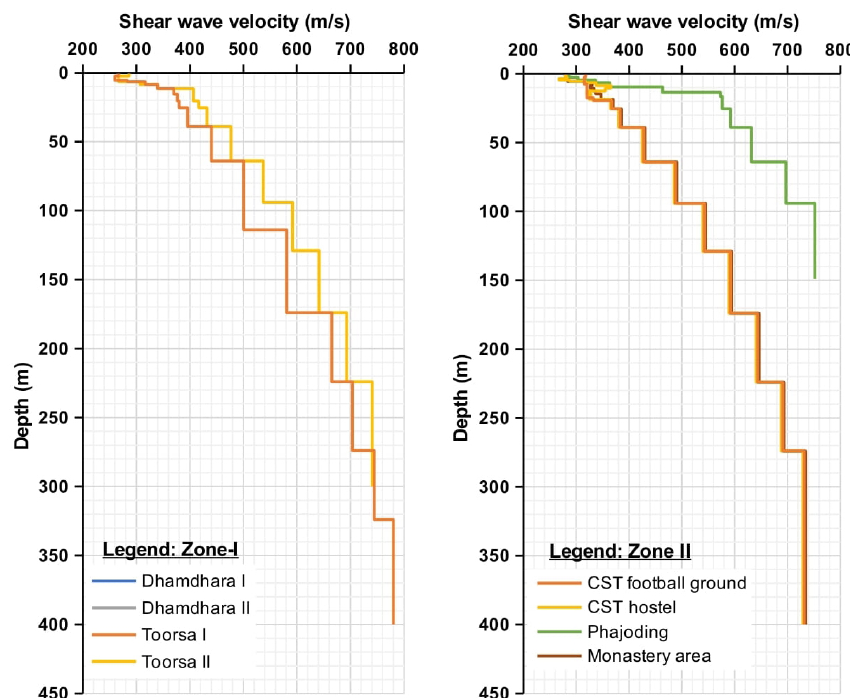
Figure 4. Shear wave velocity profile of study locations in Phuentsholing, Bhutan.